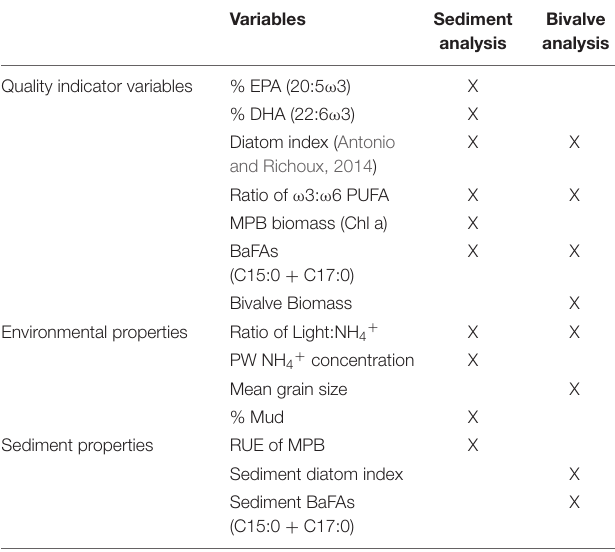
TABLE 2 | Biochemical properties and FA biomarkers used for univariate and multivariate analyses. Variables Sediment Bivalve analysis